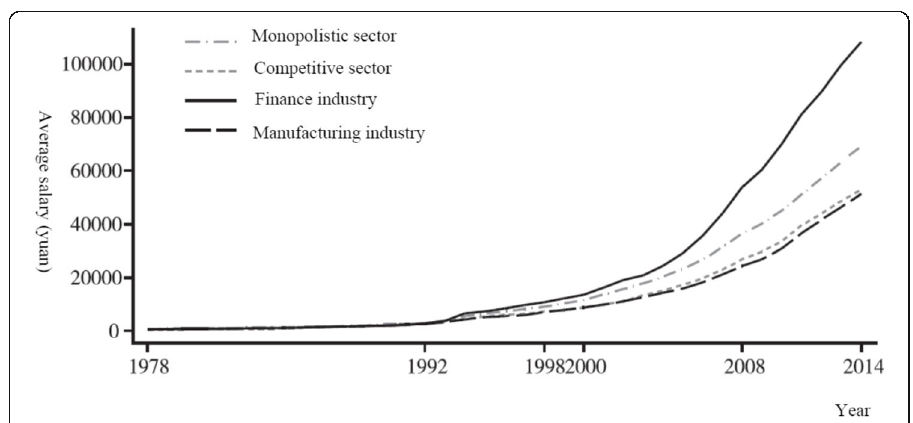
Fig. 1 Average wage of different sectors: 1978 –